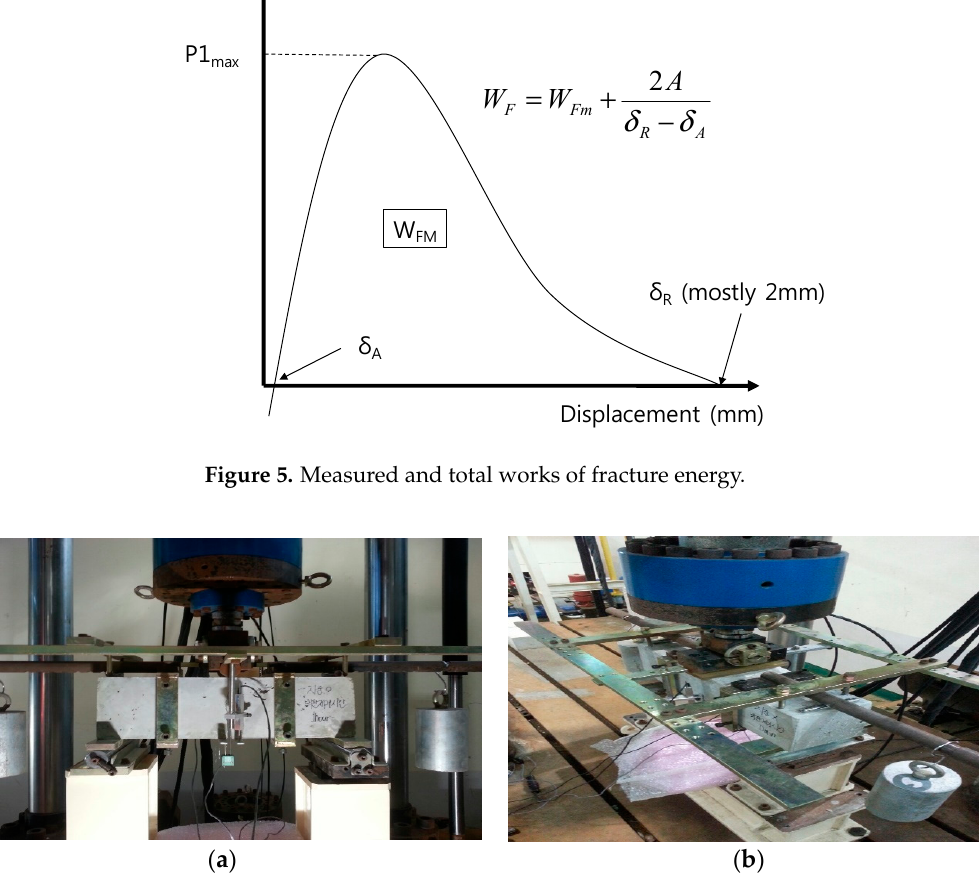
Figure 6. Three-point bending test set-up: ( a ) Front view; ( b ) Top perspective view